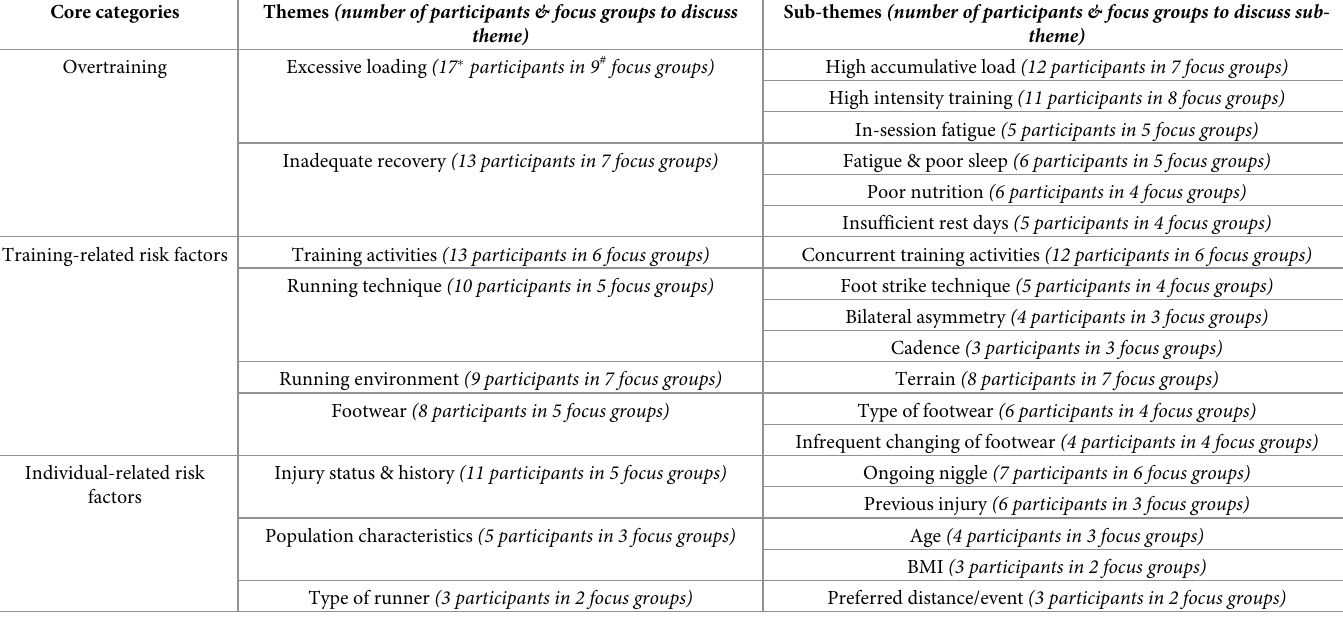
Table 2. Running-related injury risk factors perceived as important to monitor using wearable technology devices by recreational